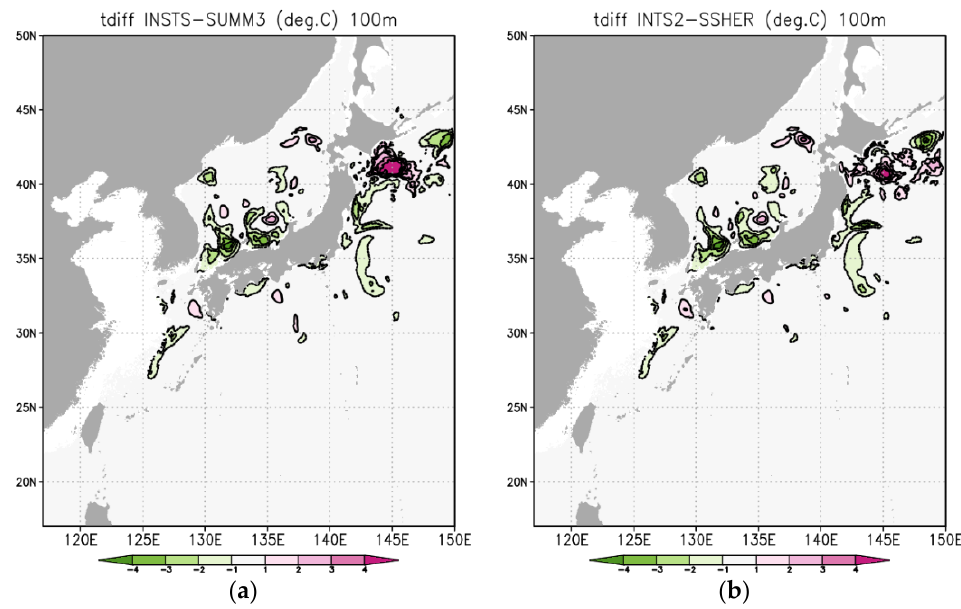
Figure 13. Mean difference in temperature (in °C) at 100 m depth for the period from 1 July to 31 August 2020 between the INSTS and SUMM3 cases ( a ) and between the INTS2 and SSHER cases ( b ).